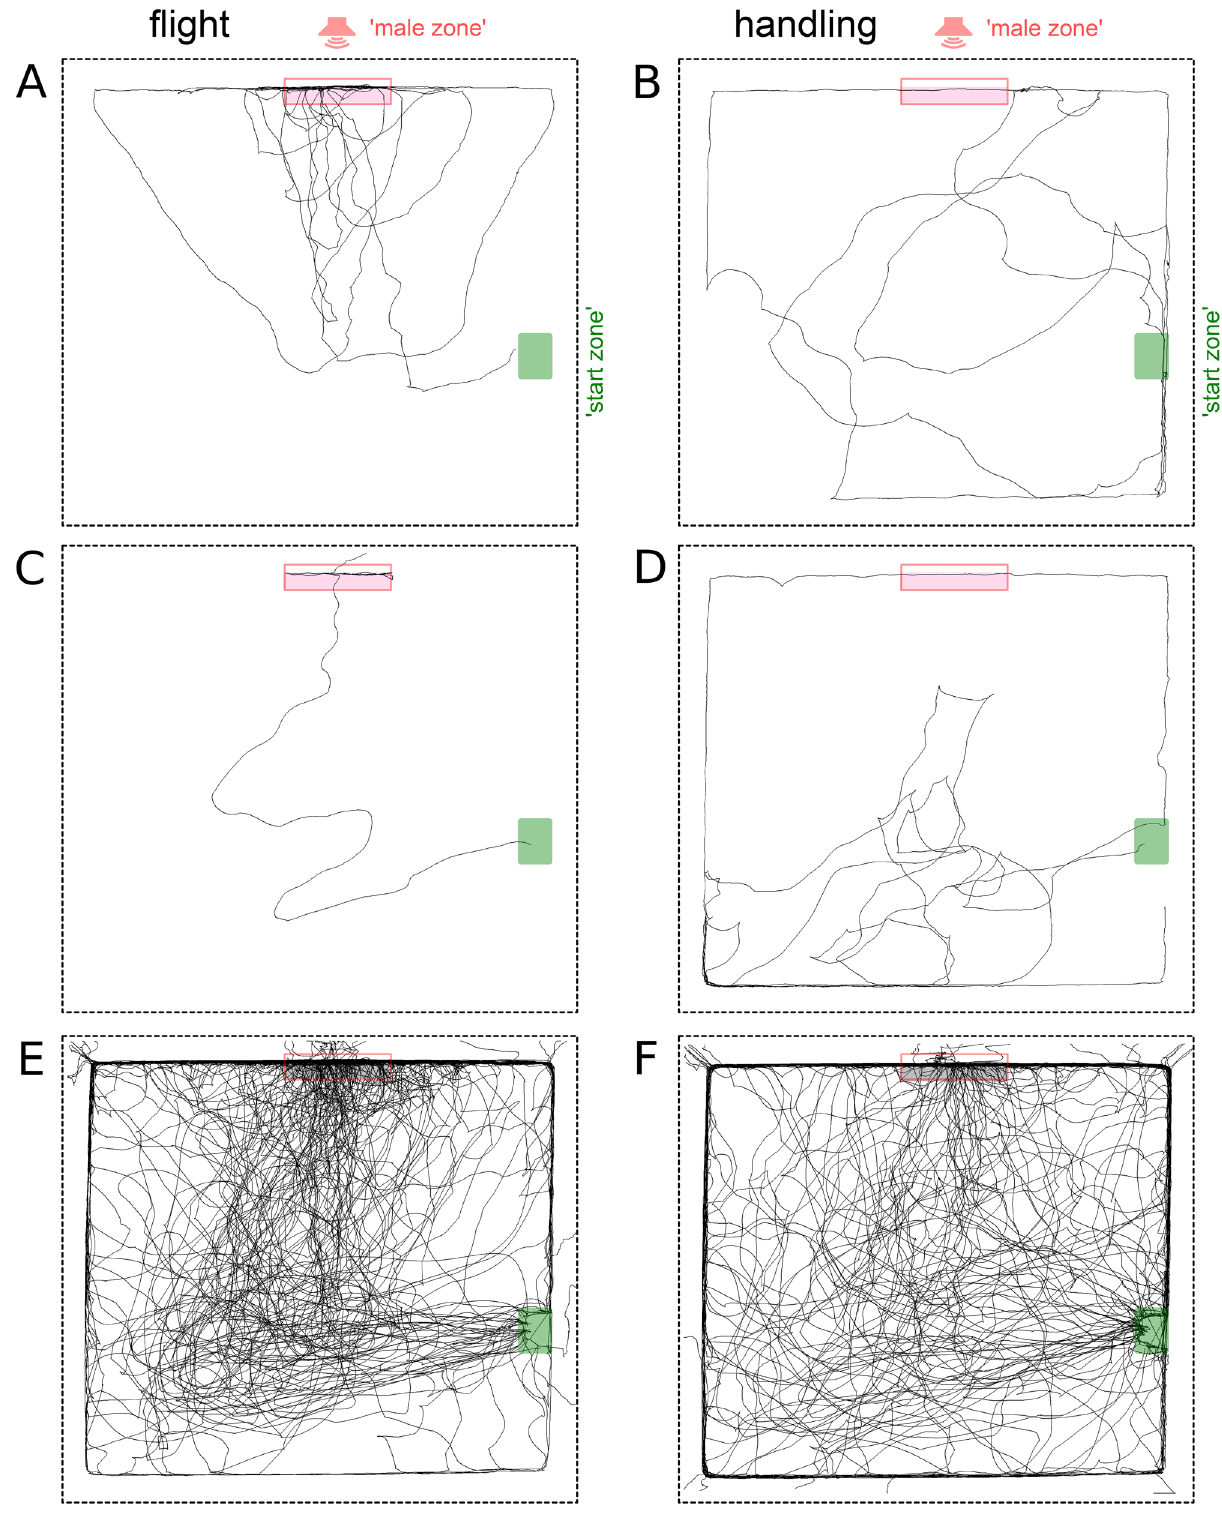
Figure 1. Visualized tracks of female crickets in the arena. (A–D) , individual tracks characteristic for ’flight’ (A,C) and ’handled’ (control) crickets (B,D) . (E,F) show the overlay of all individual tracks for ’flight’ and ’handled’ groups, respectively. The red box indicates the ’Male zone’ inside the arena and including the lower part of the wall close to the loudspeaker (situated outside the arena and hidden behind the fabric wall). The green box shows the position of the home container, in which a cricket was put into the arena and which it was allowed to leave freely. The ’flight’ crickets took a more direct path to the source of the calling song. See also Supplementary Figure S1 illustrating the distribution of cricket tracks in relation to the directional diagram of the